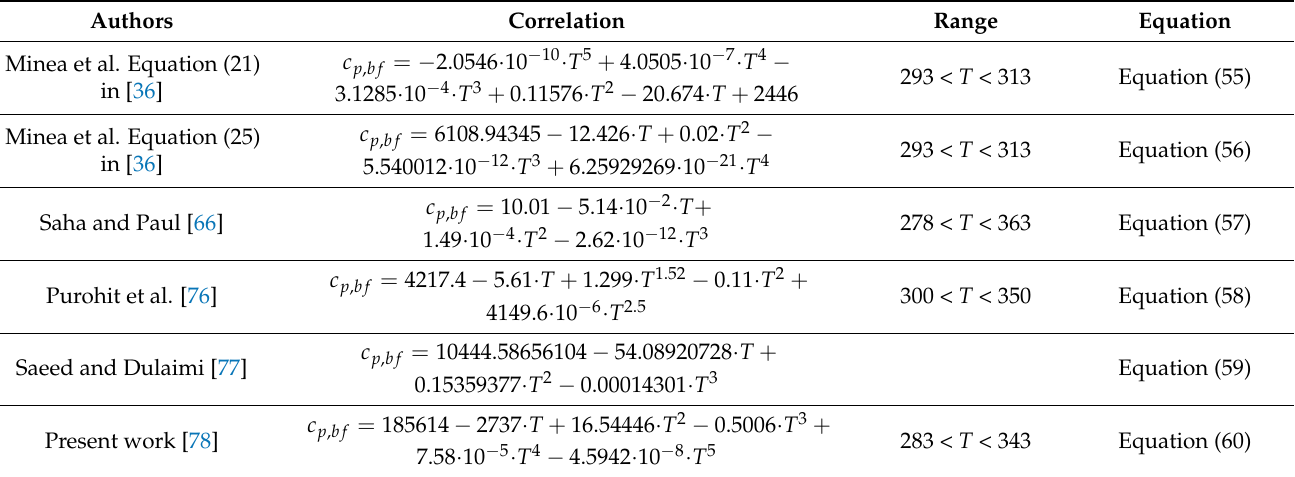
Table 11. Correlations for specific heat of